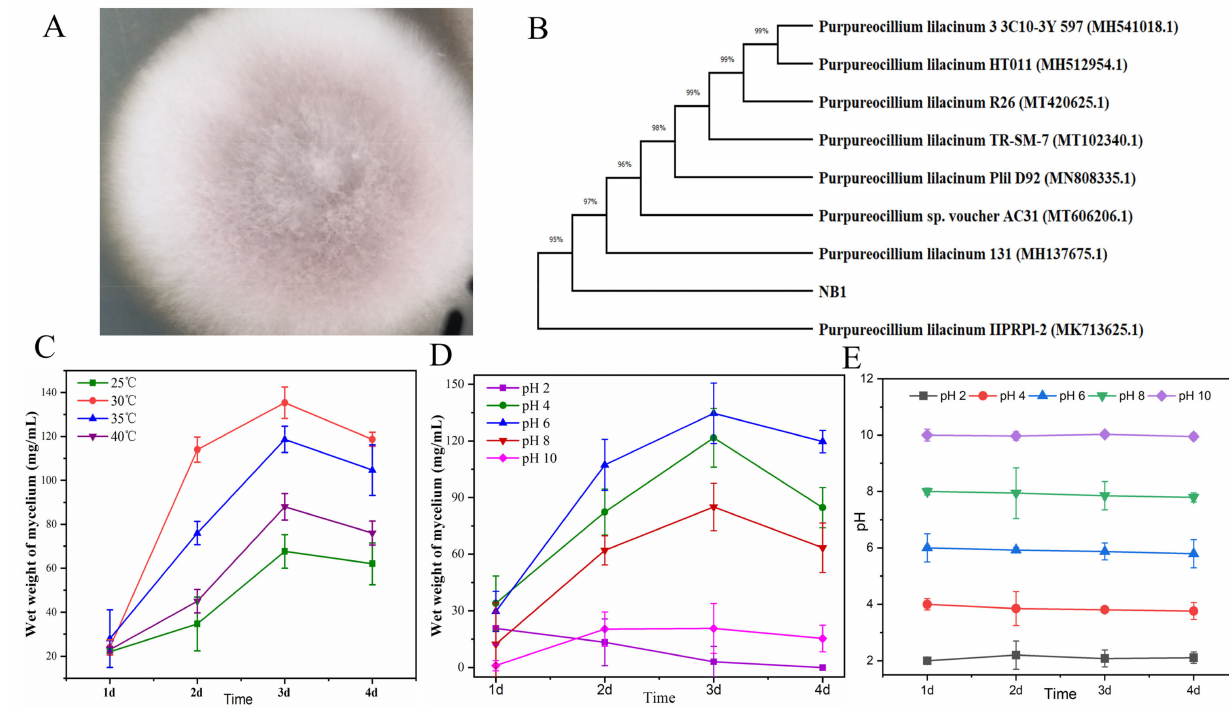
Figure 1. ( A ) The fungal morphology on the plate; ( B ) The phylogenetic tree based on the ITS DNA sequence data of P. lilacinum N1 using MEGA X; ( C ) The wet mycelial weight of P. lilacinum N1 at different temperatures and ( D ) pH; ( E ) The pH variation of supernatant at different initial pH during four